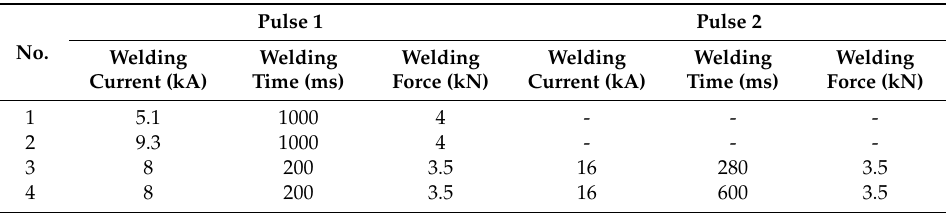
Table 2. Resistance spot welding process parameters.